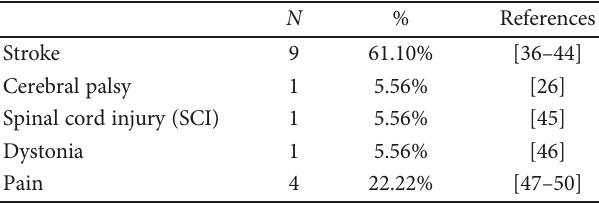
Table 5: Papers using muscle synergies in clinical practice/ rehabilitation speci fi c to the upper